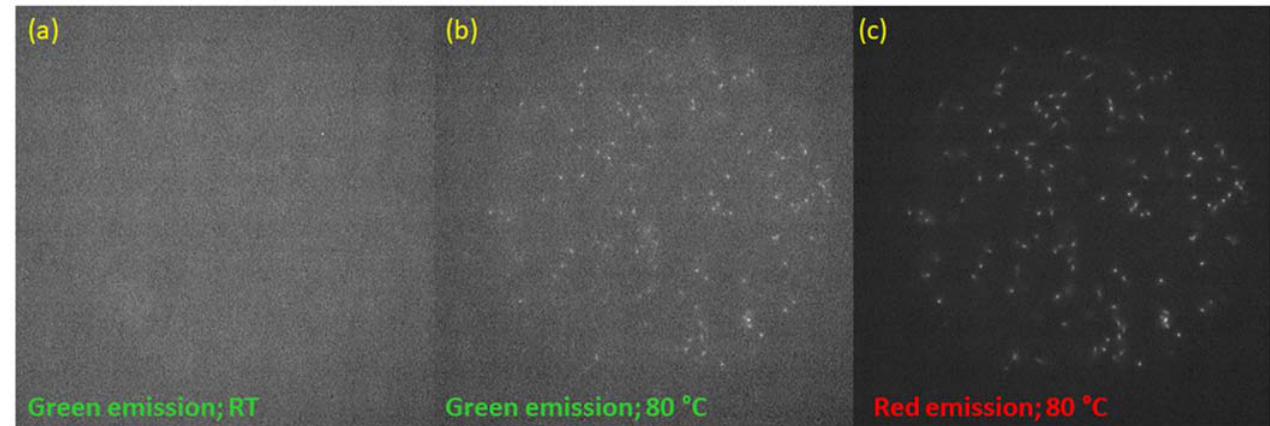
Figure 17. Microscopic images registered for the sample irradiated with alpha particles (Am ‐ 241 fluence 1.6 × 10 6 cm − 2 ): ( a ) read ‐ out at room temperature with a bandpass filter HQ 535/30 (green emission), with an acquisition time of 10 s; ( b ) read ‐ out at 80 °C with a bandpass filter HQ 535/30 (green emission), with an acquisition time of 10 s; ( c ) read ‐ out at 80 °C with a long ‐ pass filter ET570lp (red emission), with an acquisition time of 2 s.